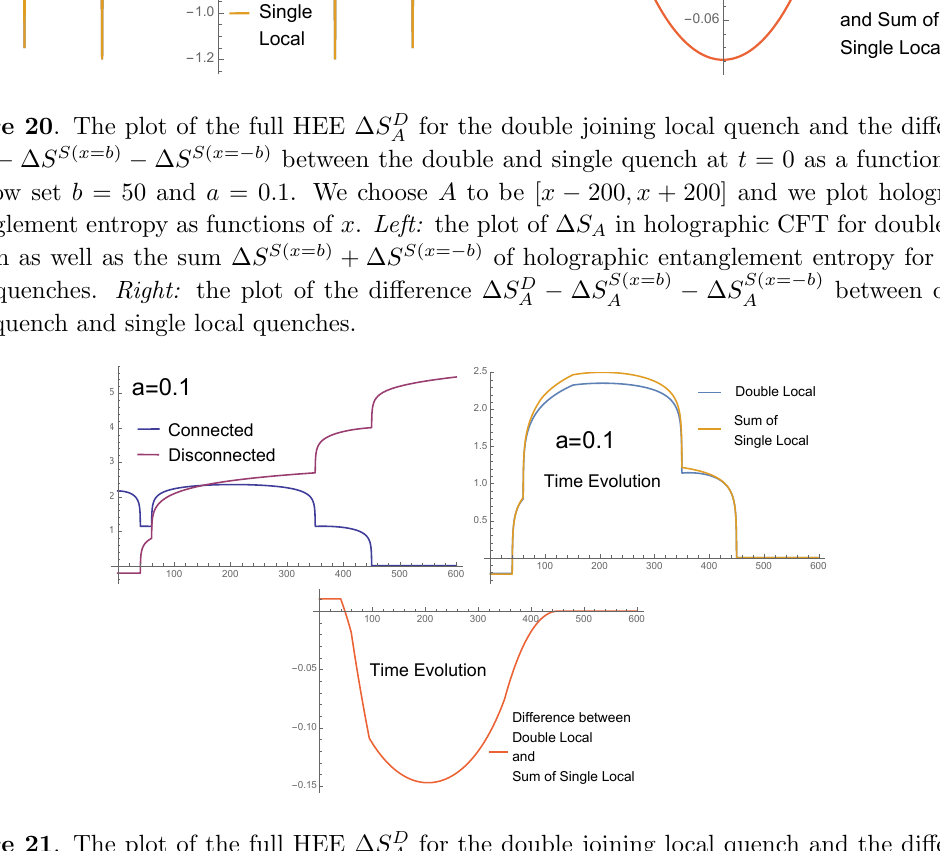
Figure 21 . The plot of the full HEE (cid:1) S D for the double joining local quench and the di(cid:11)erence A (cid:1) S D (cid:1) S S ( x = b ) (cid:1) S S ( x = (cid:0) b ) as a function of t . We set b = 50 and a = 0 : 1. We choose A to be A (cid:0) (cid:0) [10 ; 400]. Left: in the left plots, the blue and red graph describe (cid:1) S con and (cid:1) S dis , respectively. A A S ( x = b ) Middle: the plot of (cid:1) S + (cid:1) S S ( x = (cid:0) b ) for A for double local quench as well as the sum (cid:1) S A A single local quenches. Right: the plot of the di(cid:11)erence (cid:1) S D (cid:1) S S ( x = b ) (cid:1) S S ( x = (cid:0) b ) between A (cid:0) A (cid:0) A double local quench and single local